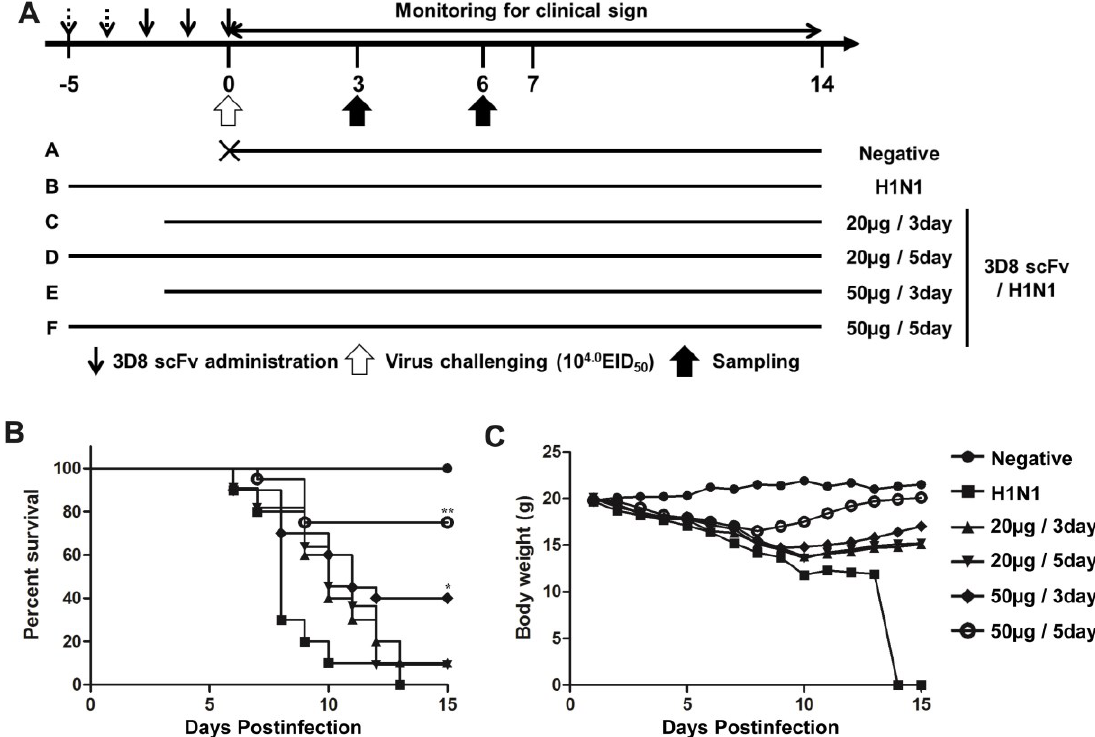
Figure 2. Antiviral effects of intranasally administrated 3D8 scFv on survival and body weight. ( A ) BALB/c mice were treated intranasally with 3D8 scFv protein (50 μg/mouse) for 3 or 5 days before infection with A/NWS/33; ( B , C ) Mice were monitored daily for 14 days to determine the rate of survival ( B ) and changes in body weight ( C ). Control group, n = 10; positive control group, n = 10; treatment groups, n = 10. Asterisks indicate significant differences ( * p < 0.05, ** p < 0.01) compared with the positive (H1N1) control group (Fisher’s exact test).